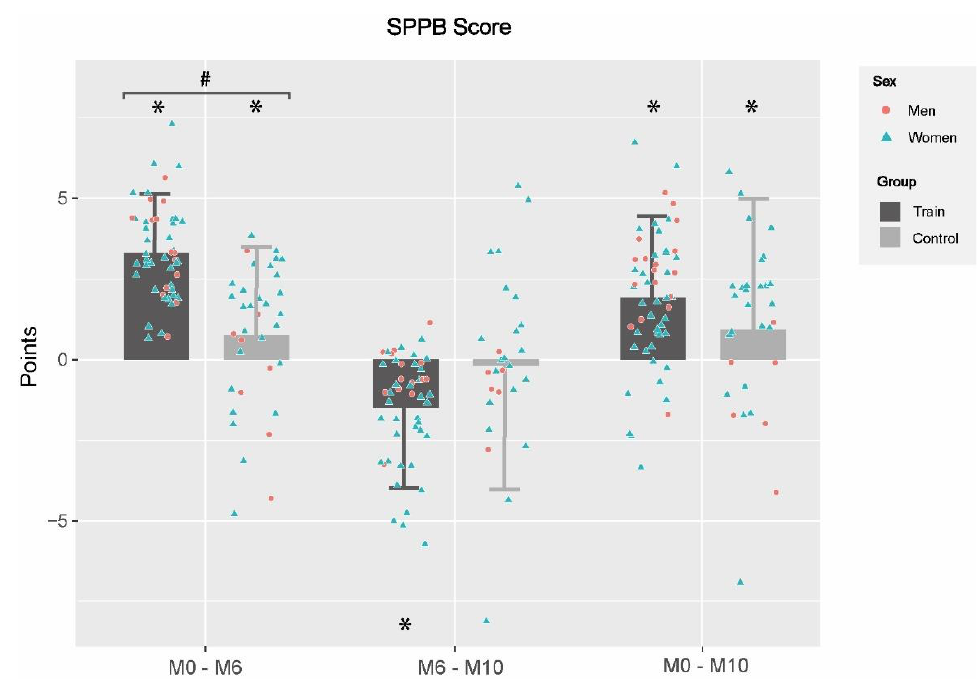
Figure 1. Changes in functional capacity between and within groups in different evaluation periods.